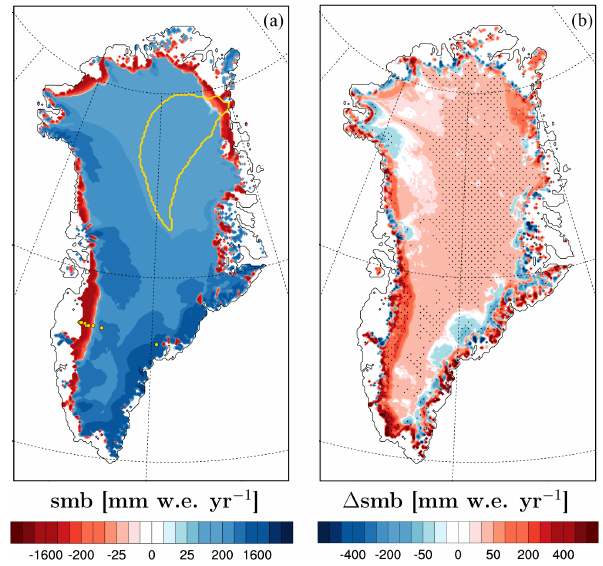
Figure 6. (a) SMB (mmw.e.yr − 1 ) averaged for the period 1958– 2015. The combined Zachariae Isstrøm and Nioghalvfjerdsbrae (79 ◦ N) glacier basins are delineated by the yellow line. Yellow dots locate the K-transect measurement sites in western Greenland and the single AWS operated in south-eastern Greenland. (b) SMB dif- ference (mmw.e.yr − 1 ) between RACMO2.3p2 and RACMO2.3p1 for the period 1958–2015. Areas showing significant difference are stippled in panel (b) : difference exceeds 1 standard deviation of the difference between the two model